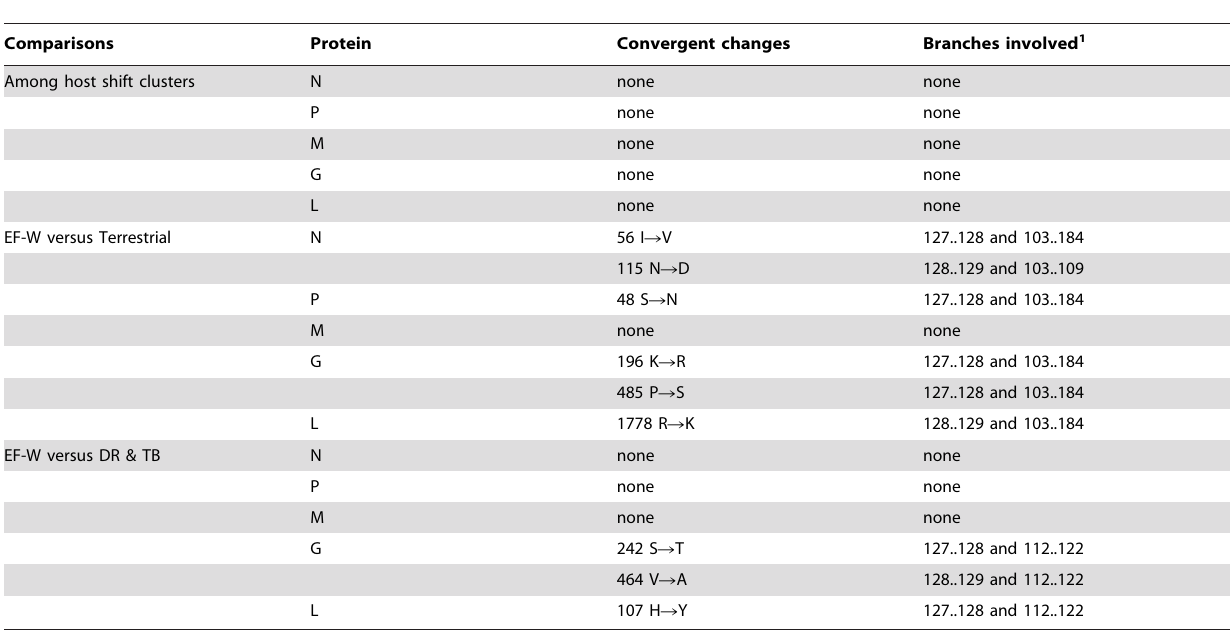
Table 2. Convergent changes among branches of interest in the bat and terrestrial RABV datasets.